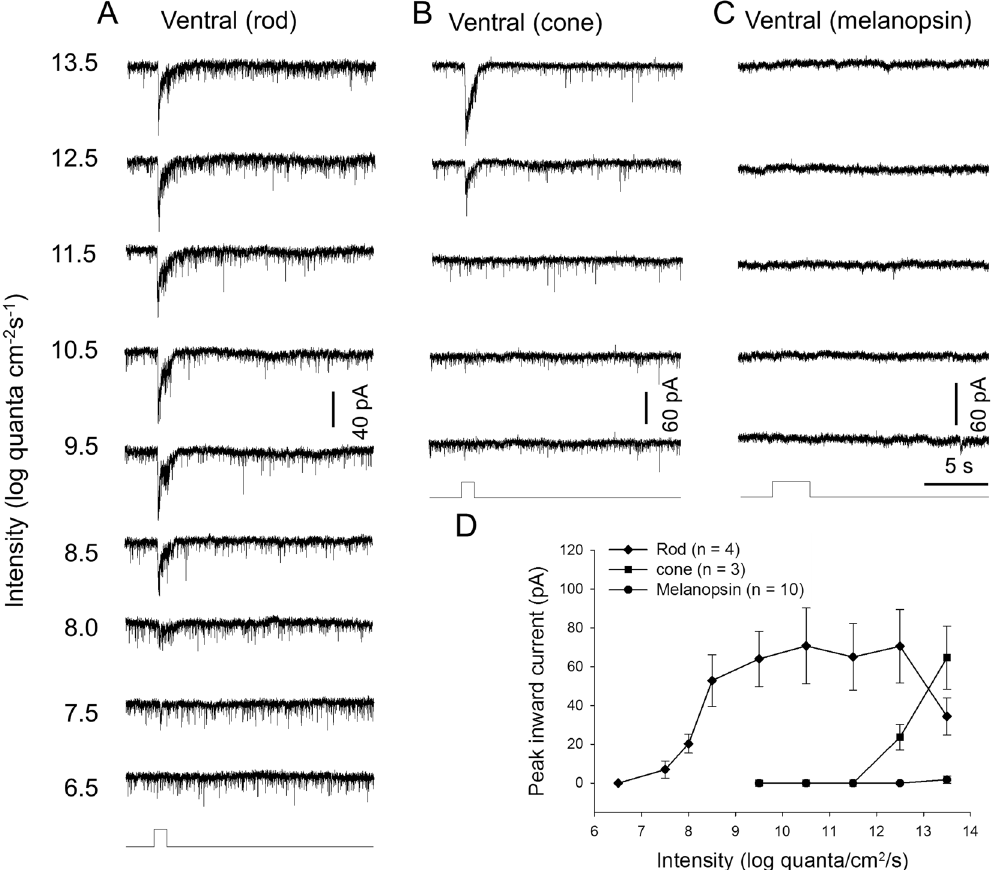
Figure 3. Relative contributions of rods, M-cones and melanopsin to dark-adapted ventral DAC light responses. Light-evoked EPSCs of a dark-adapted dorsal DAC in a rod-function-only retina showing the cell’s response to a series of light stimuli ranging in intensity from 7.5 to 13.5 log quanta/cm 2 /s ( A ). M-cone-mediated responses of a DAC in a cone-function-only retina ( B ) demonstrate that its threshold intensity is five log units greater than that of rod-mediated responses. Melanopsin-based responses of a DAC were undetectable in this cell ( C ). Stimulation bar shows timing of light pulse (1-s duration, white light pulse). ( D ) Intensity-response profiles showing the average peak amplitudes of DAC light-evoked EPSCs as a function of the light intensity. Closed circles: rod-mediated responses; closed squares, M-cone-mediated responses; closed diamonds, melanopsin-based responses. Each data point shows the average and SE of multiple